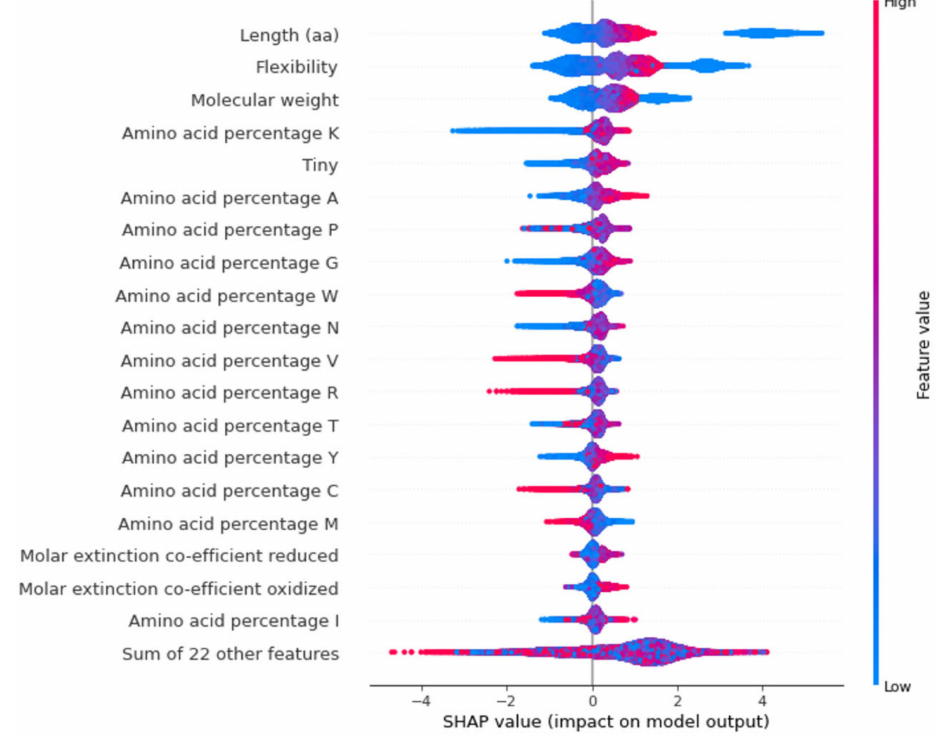
Figure 6. Beeswarm plot for top 20 features that contribute to protein model. Each dot indicates one value, and they pile up in each row to show density. The red dots represent higher feature value while the blue dots represent lower feature value. The positive side indicates high confidence genes while the negative side indicates low confidence